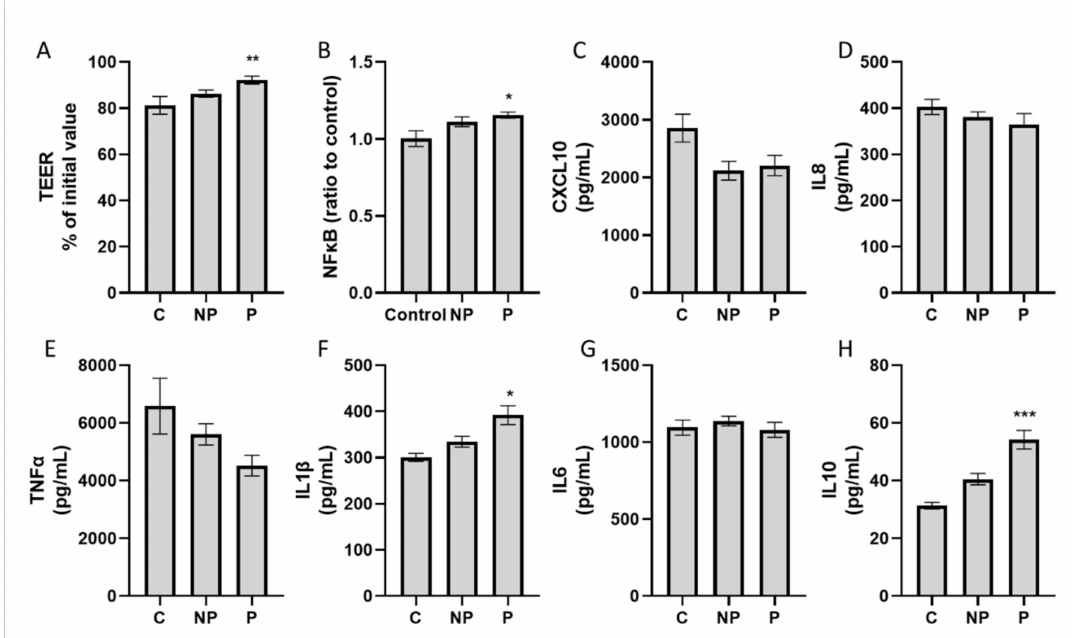
Figure 6. Effect of kefir on the intestinal barrier and immunomodulation. Bars represent the mean ± SEM (n ≥ 3) for TEER percentages of the initial value ( A ), NF- κβ activity of THP1 cells ( B ), CXCL10 ( C ), IL8 ( D ), TNF α ( E ), IL1 β ( F ), IL6 ( G ) and IL10 ( H ). Significant differences between control condition and treatments marked by (*), (**) and (***) for p < 0.05, p < 0.01 and p < 0.001,